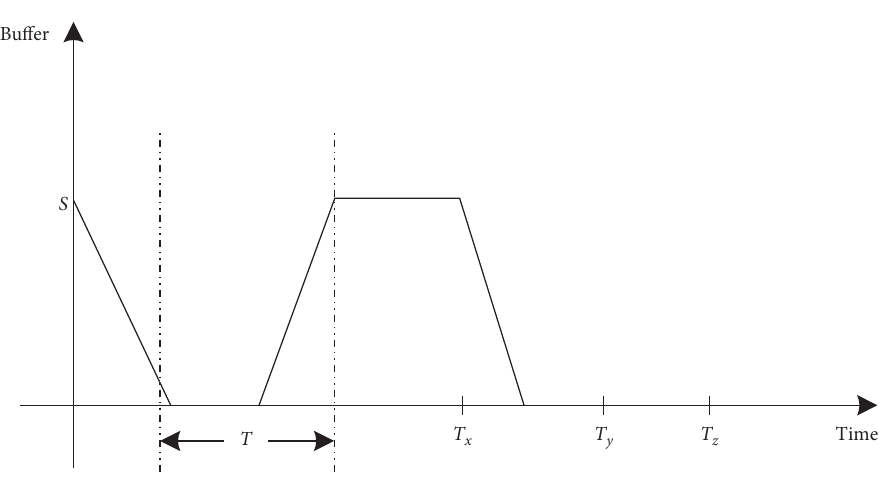
Figure 4: Buffer stock change diagram in a cycle for 0 < T < T